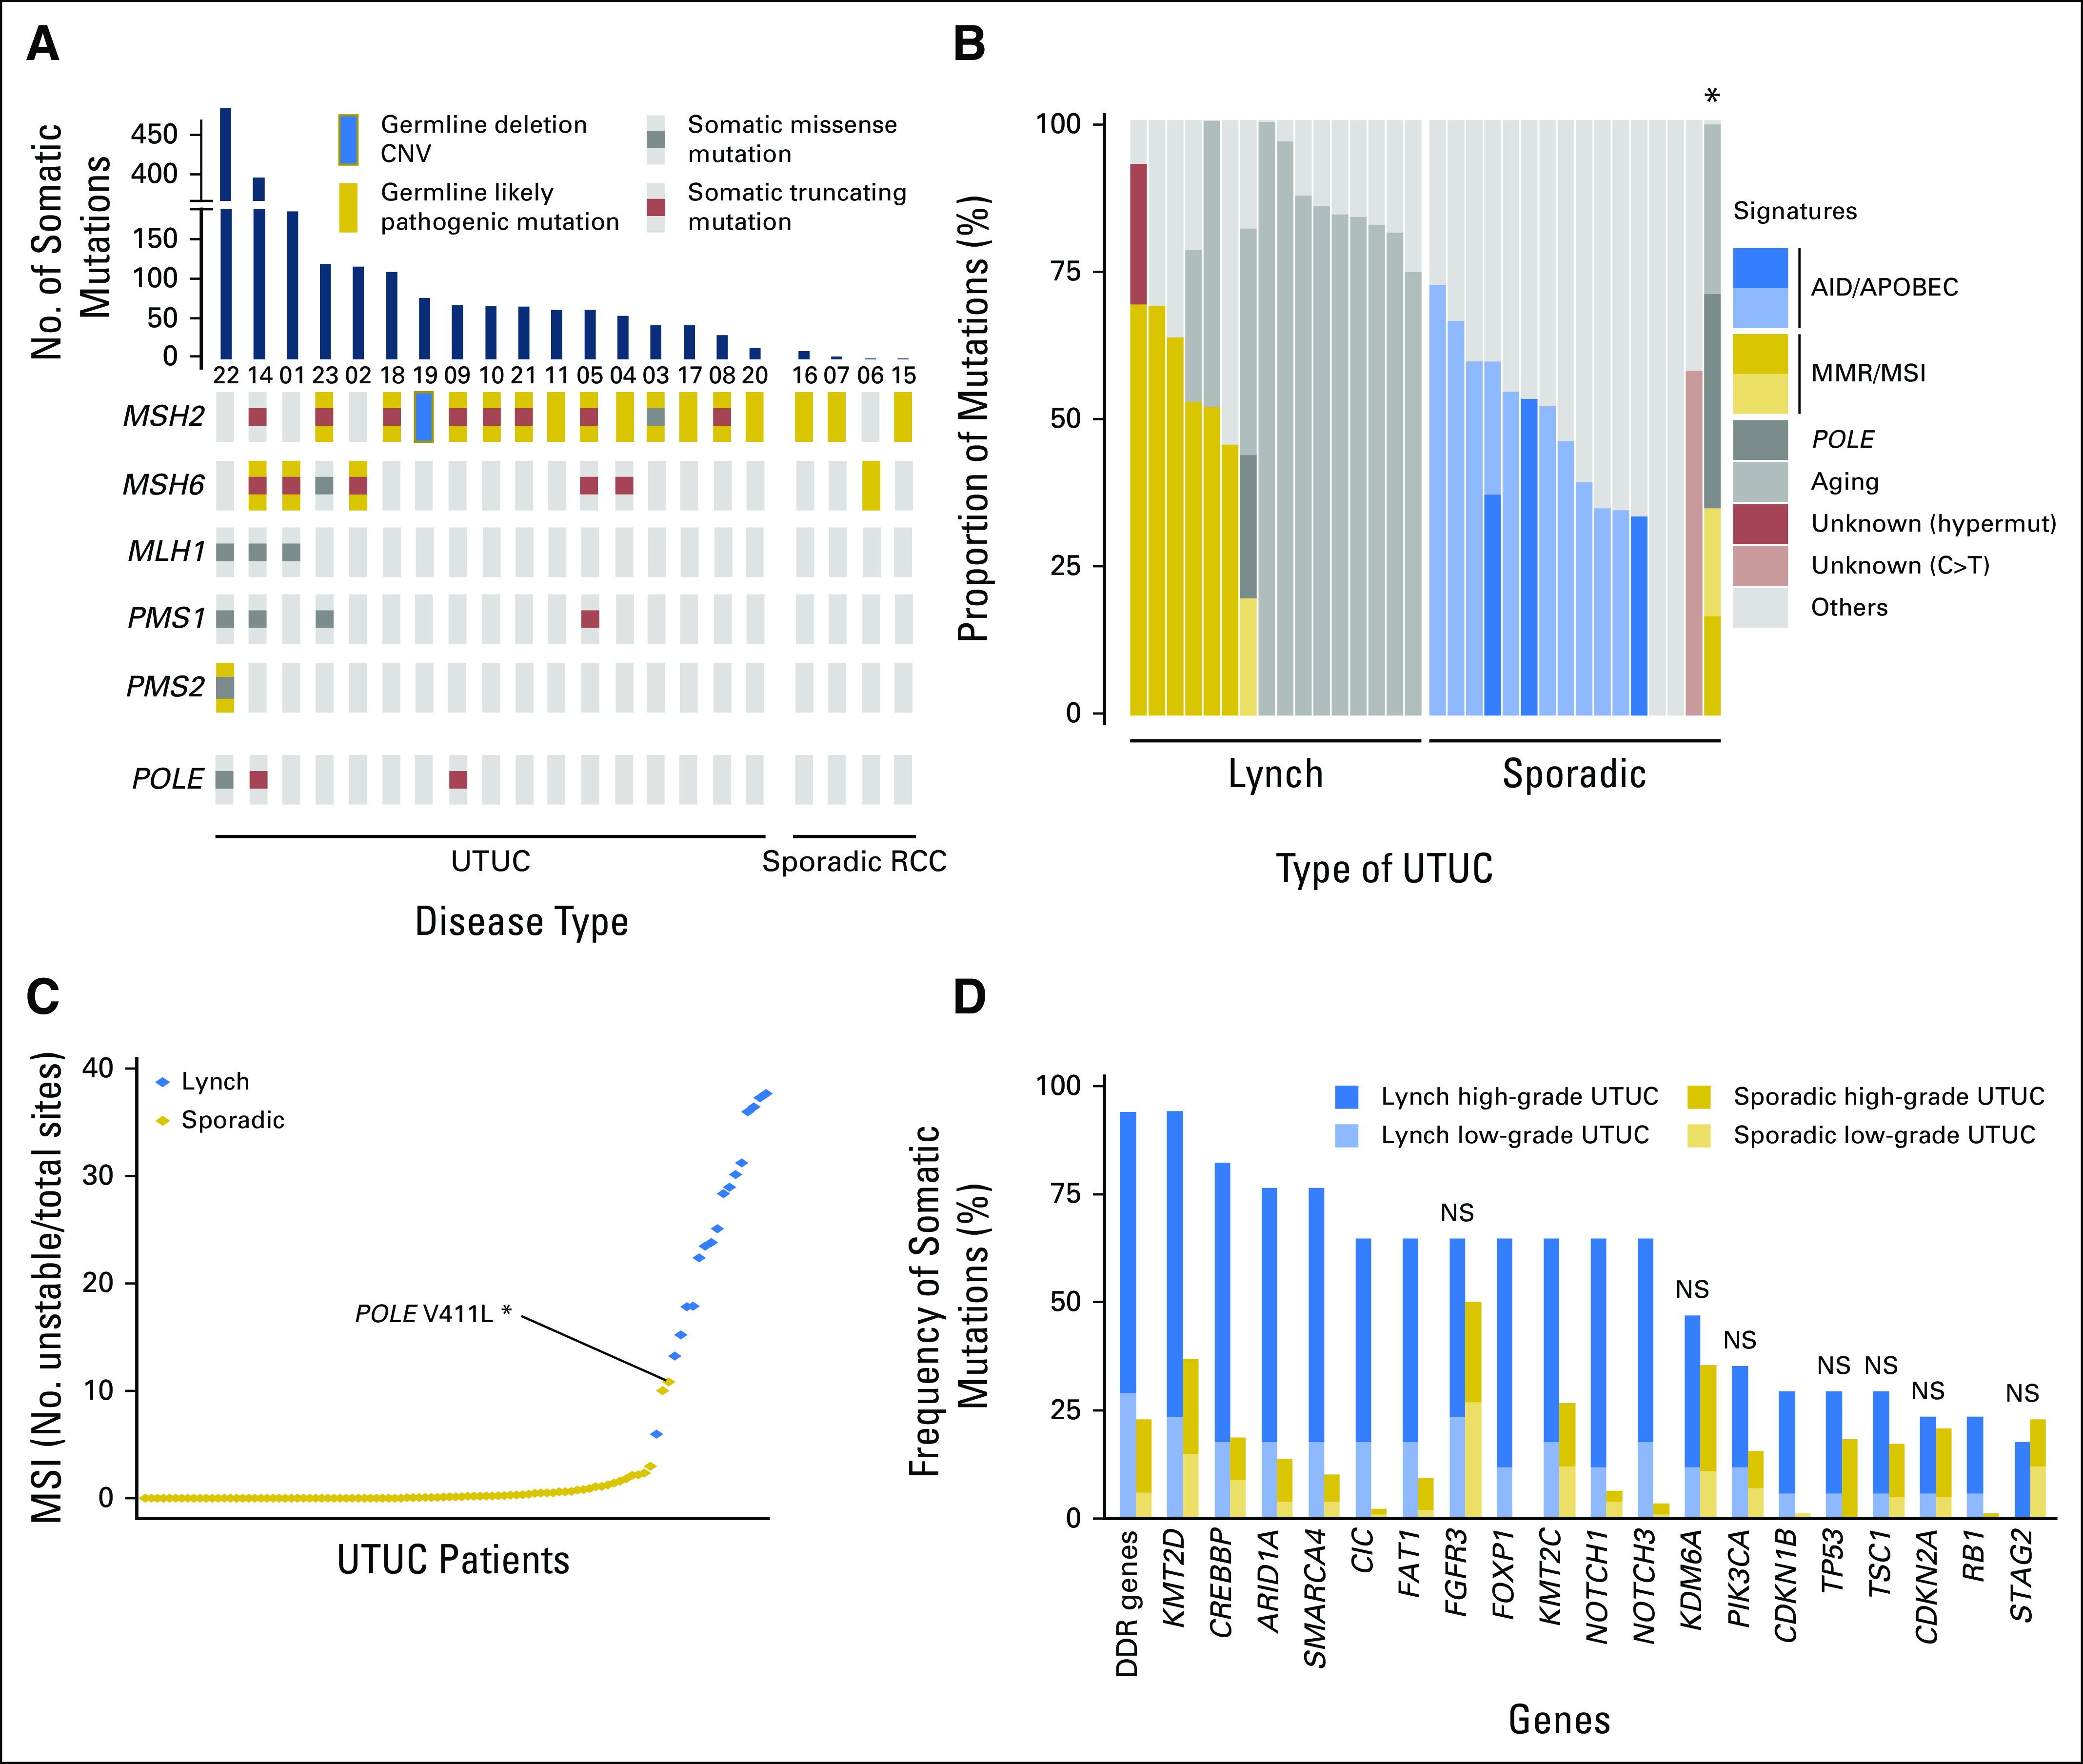
(A) Oncoprint of germline and somatic mutations in mismatch repair (MMR) genes and in POLE in the Lynch cohort. (B) Mutational decomposition analysis of the samples with ≥ 10 somatic mutations. (*) Hypermutated sporadic upper-tract urothelial carcinoma (UTUC) tumor with a hotspot mutation in POLE. (C) Microsatellite instability (MSI) sensor scores across the two cohorts. (D) Frequency of somatic alterations in Lynch syndrome–associated (n = 17) and sporadic UTUC (n = 82) cohorts. AID/APOBEC, activation-induced cytidine deaminase/apolipoprotein B mRNA-editing enzyme catalytic polypeptide; CNV, copy-number variation; DDR, DNA damage repair; NS, non significant; RCC, renal cell carcinoma.